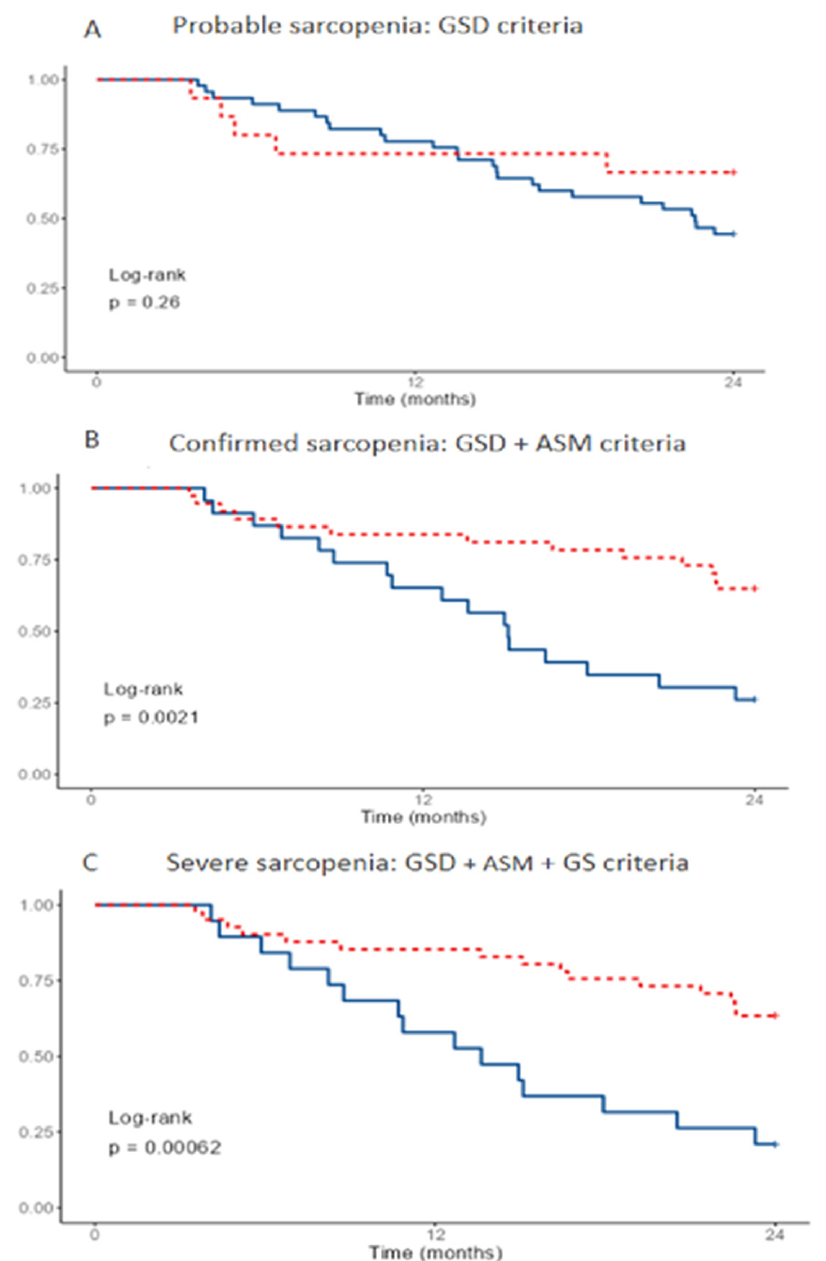
Figure 1. Survival according to the EGWSOP2 criteria at 24 months. Vertical axis shows survival. Probable of severe sarcopenia in blue, no sarcopenia in discontinuous red. Survivors, n = 30. Deceased, n = 30. GSD: grip strength by dynamometry, ASM: appendicular skeletal muscle mass, GS: gait